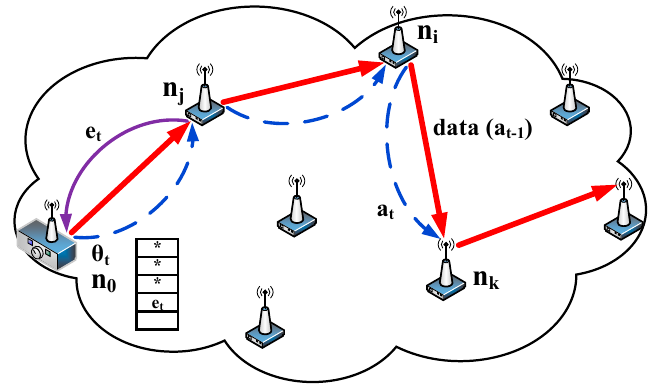
Figure 4. Implementation of PM-DQfD-based cross-layer routing scheme.